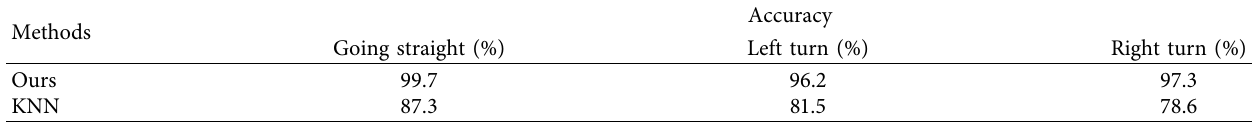
Figure 10: Relationship between the length of the sliding pane and the training mean square error. Table 3: Comparison of accuracy of different turning recognition methods.